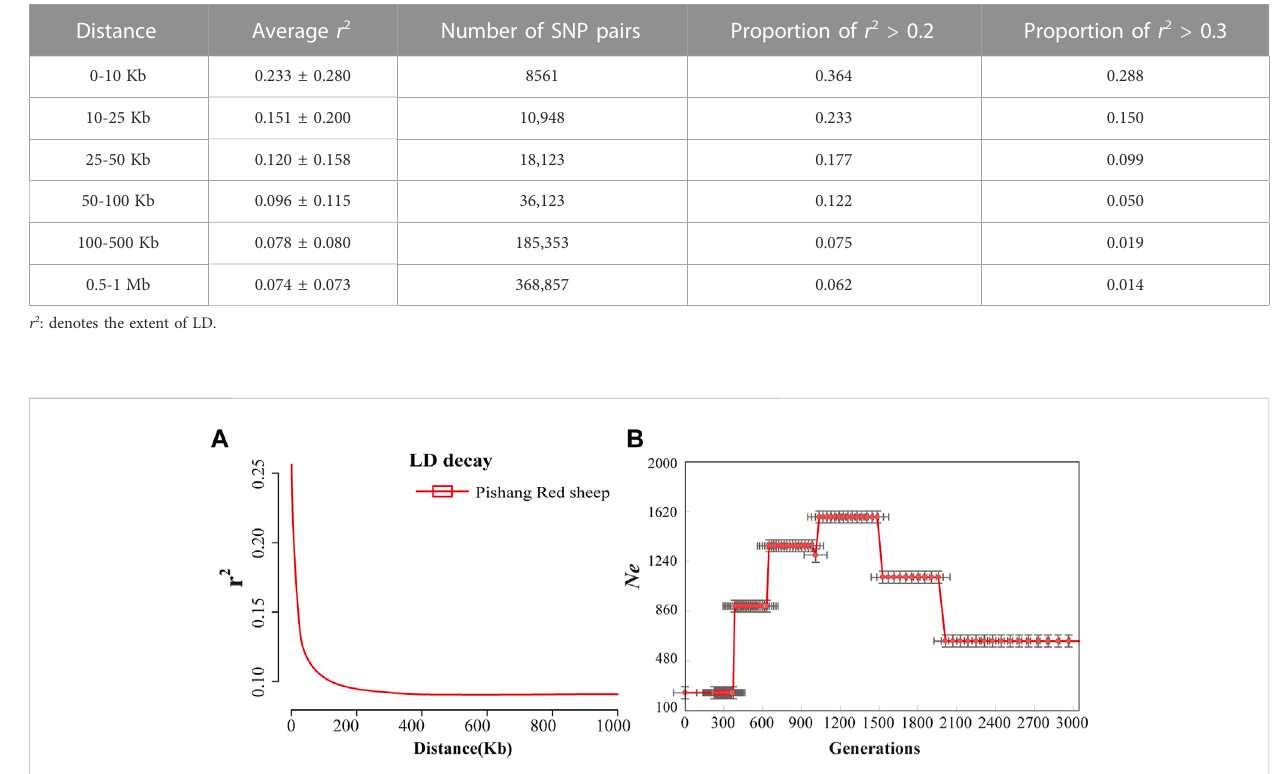
FIGURE 1 LD decay and Ne in PRS. (A) : Distribution of average r 2 values for PRS with respect to physical distance (kb) in 1,000 kb windows. (B) : Genome-wide LD ( r 2 ) between SNPs was used to estimate the Ne of the